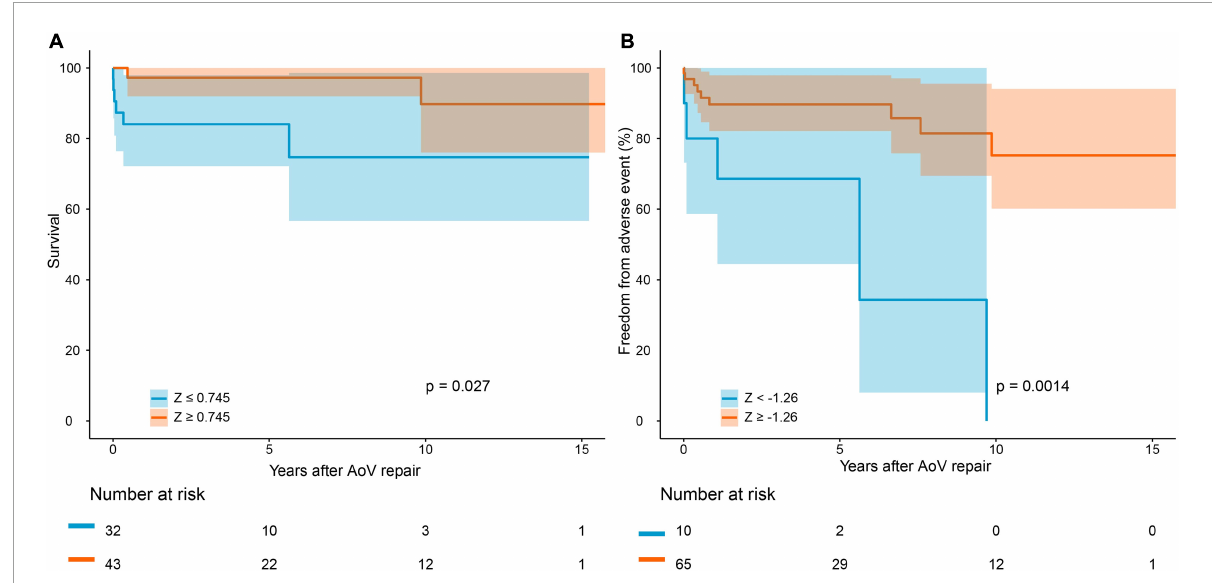
FIGURE4 Survival after AoV repair (A) and freedom from adverse event (B) in patients with different aortic annulus diameter Z -score.